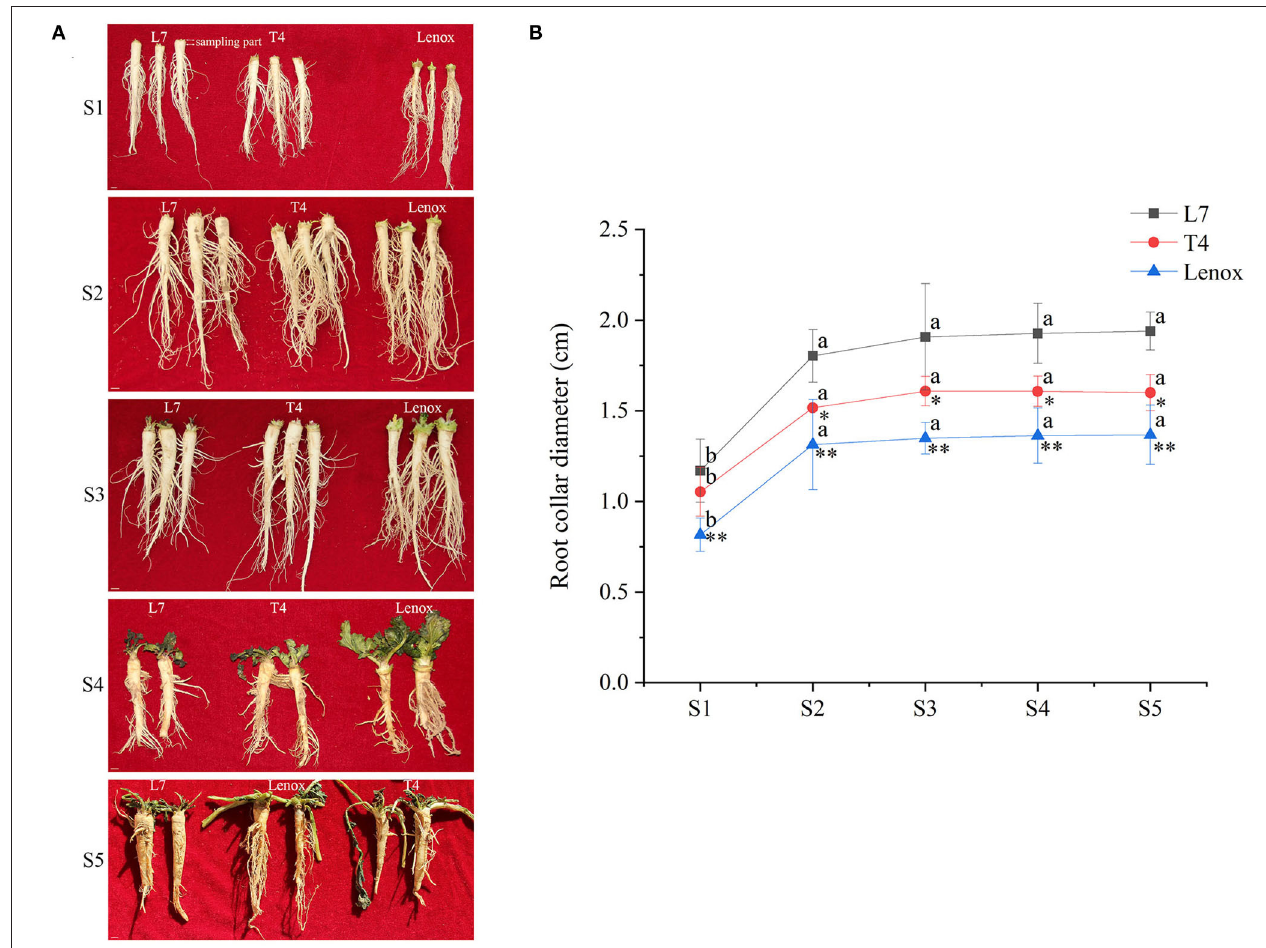
FIGURE 1 | Morphological characteristics of roots of three winter turnip rape varieties. (A) Phenotype of roots during five sampling stages. S1, S2, S3, S4, and S5 represent the pre-winter period (S1) and overwintering periods (S2–S5), respectively. The scale bar is 1cm. (B) Root collar diameter in winter. Samples ( n ≥ 5) were measured every sampling date. Letters indicate significant differences between different stages of each variety compared to the S1 stage, and asterisks indicate significant differences between different varieties compared to Longyou-7 (L7) in every stage (* p < 0.05, ** p < 0.01,